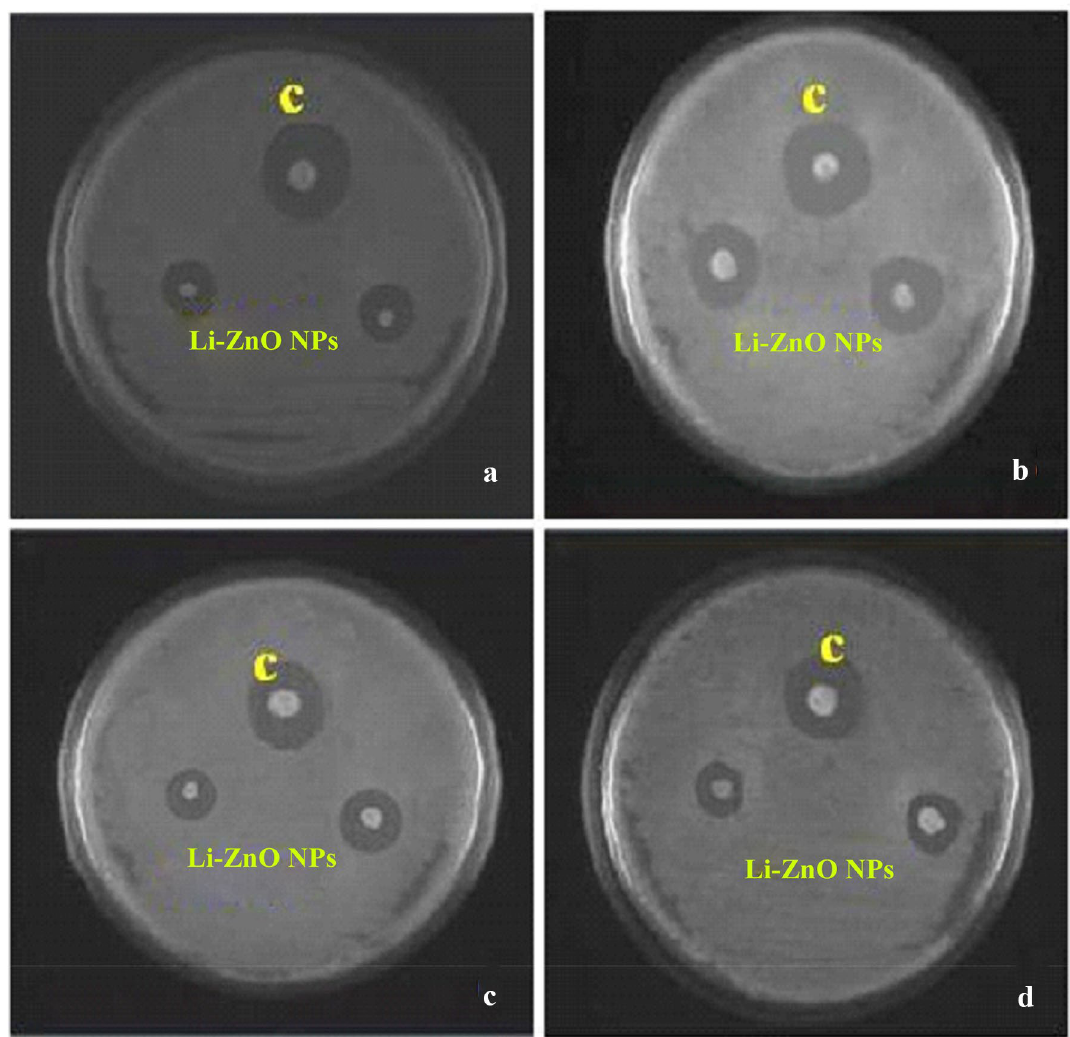
Figure 6. Inhibitory zone of ZnO NPs against pathogenic bacteria and fungi. ( A ) Escherichia coli , ( B ) Bacillus subtilis, ( C ) Alternaria alternate , ( D ) Aspergillus flavus ; Standard: tetracycline for bacteria and fluconazole for fungi.